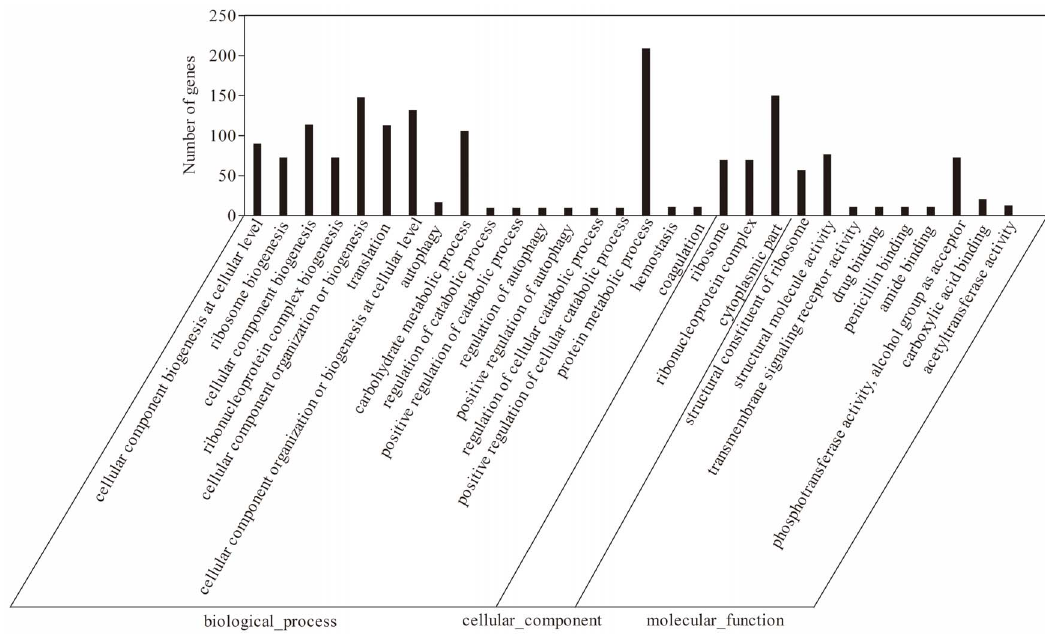
Figure 4. GO analysis of differentially expressed genes in T.tengcongensis with and without cold shock.